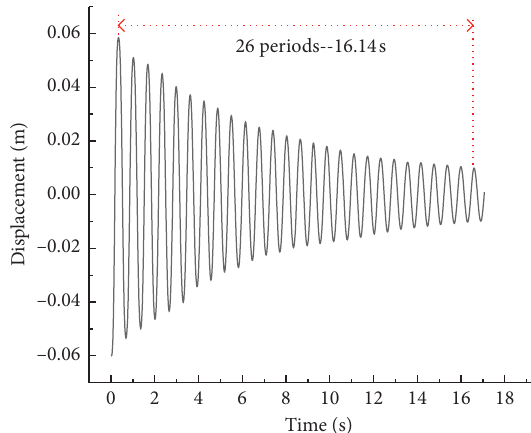
Figure 5: The displacement curve of the rolling